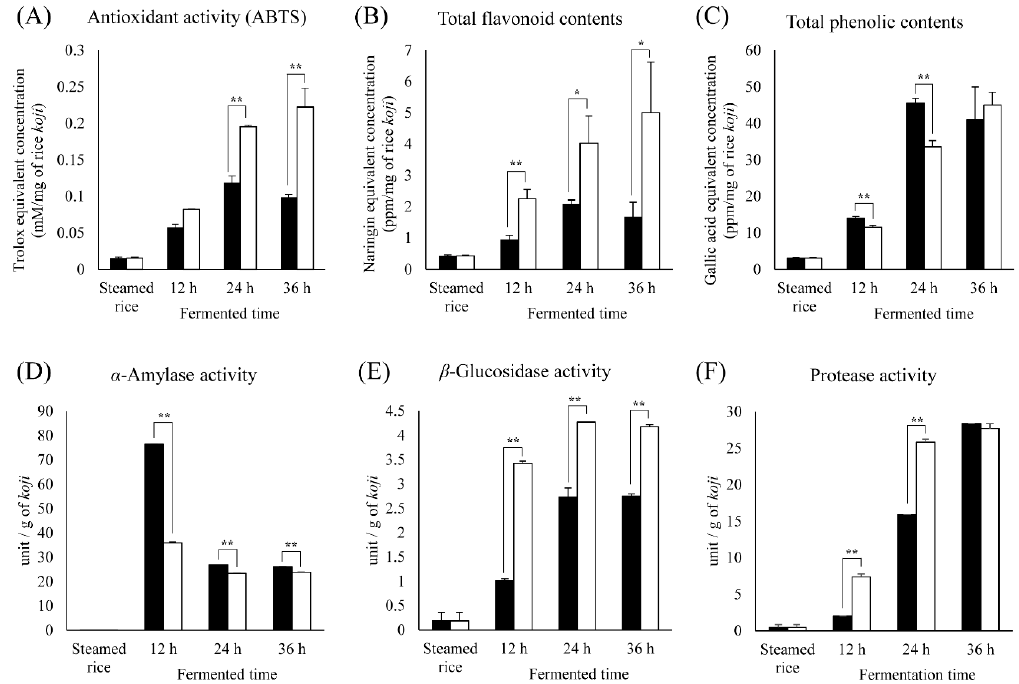
Figure 4. Comparison of bioactivities and enzymatic activities for rice koji fermented with A. oryzae (RK_ AO , filled columns) or B. amyloliquefaciens (RK_ BA , unfilled columns) for different durations. The bioactivities are antioxidant activity (ABTS) ( A ); total flavonoid contents ( B ); and total phenolic contents ( C ); The enzymatic activities are α -amylase activity ( D ); β -glucosidase activity ( E ); and protease activity ( F ). Significant differences between the RK_ AO and RK_ BA groups were identified by t -test (* p < 0.05, ** p < 0.01).